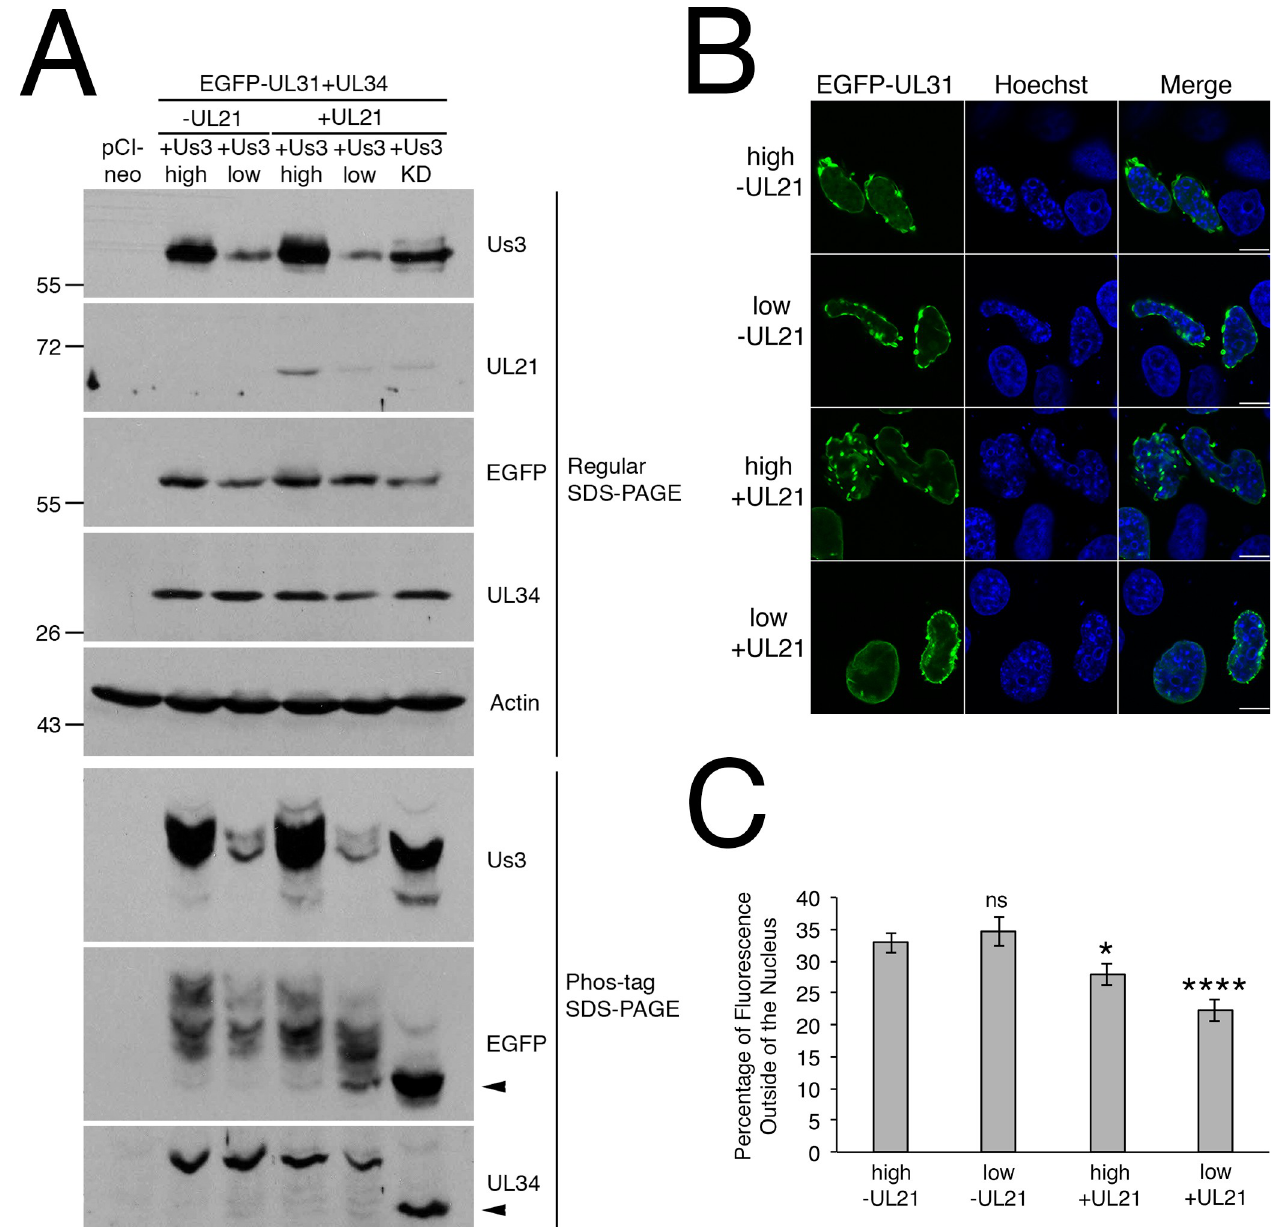
Fig 8. Impact of pUL21 on pUs3-mediated phosphorylation of NEC components in transfected cells. (A) HeLa cells were transfected or co-transfected with the expression plasmid(s) indicated above each lane. In the case of samples designated high, equal amounts of each expression plasmid were included in transfection mixes. In the case of samples designated low, 10-fold less pUs3 expression plasmid was included in transfection mixes and an appropriate amount empty pCI-neo vector was included to normalize the amount of DNA in the transfection mix. In transfection mixes lacking pUL21 expression plasmid, an equivalent amount of empty pCI-neo vector was substituted to normalize the amount of DNA in the transfection mix. Equal volumes of protein extracts prepared at 18 hours post transfection were electrophoresed through regular or phos-tag SDS polyacrylamide gels and proteins transferred to PVDF membranes. Membranes were probed with antisera indicated on the right side of each panel. Molecular weight markers in kDa are indicated on the left side of the panels. Black arrowheads denote the position of unphosphorylated protein species. (B) HeLa cells were co-transfected with EGFP-pUL31 and pUL34 expression plasmids along with high or low amounts of pUs3 expression plasmid in the presence or absence of pUL21 expression plasmid, as indicated on the left of each panel. At 18 hours post transfection, cells were fixed and nuclei were stained with Hoechst 33342. Representative images of cells with bright fluorescence indicative of robust NEC production are shown. Scale bars are 10 μ m. (C) HeLa cells were co-transfected, fixed and stained as described in (B) . Images of 80 cells were captured for each condition and the percentage of fluorescence outside of the nucleus for each image was determined as described in Materials and Methods. Error bars are standard error of the mean. Asterisks denote significant decreases in the percentage of fluorescence outside of the nucleus in comparison to that of co-transfection with EGPF-pUL31, pUL34 and high amount of pUs3, determined by Student’s T test; � = P value < 0.05, ���� = P value <